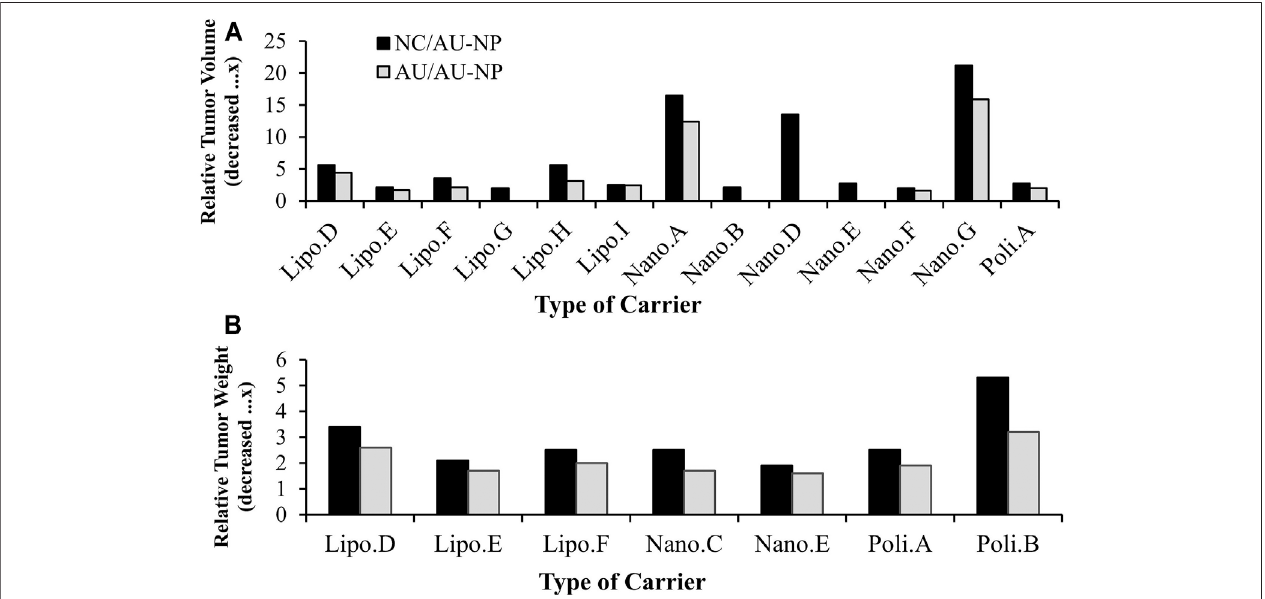
FIGURE 5 | (A) Relative tumor volume in animal models treated with UA-loaded nanoparticles compared to negative control (black bars) and UA-free treatment groups (grey bars), (B) relative tumor tissue weight of animal models treated with UA-loaded nanoparticles compared to negative control (black bars) and native UA- treatment groups (grey